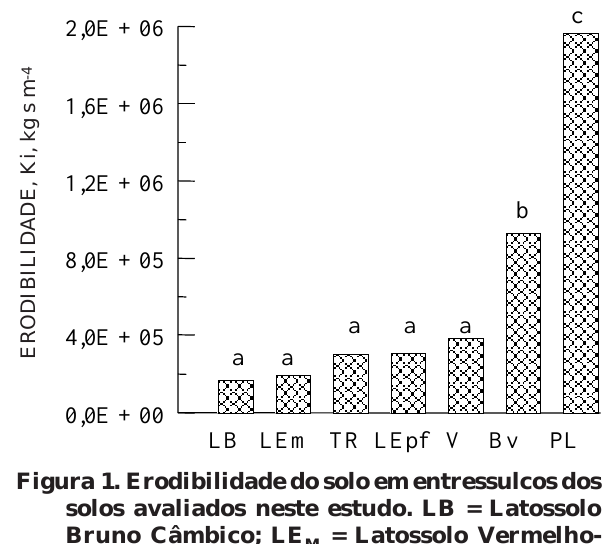
Figura 1. Erodibilidade do solo em entressulcos dos solos avaliados neste estudo. LB = Latossolo Bruno Câmbico; LE = Latossolo Vermelho- M Escuro de Marau; TR = Terra Roxa Estruturada; = Latossolo Vermelho-Escuro de Passo LE PF Fundo; V = Vertissolo; Bv = Brunizém Vértico; PL =